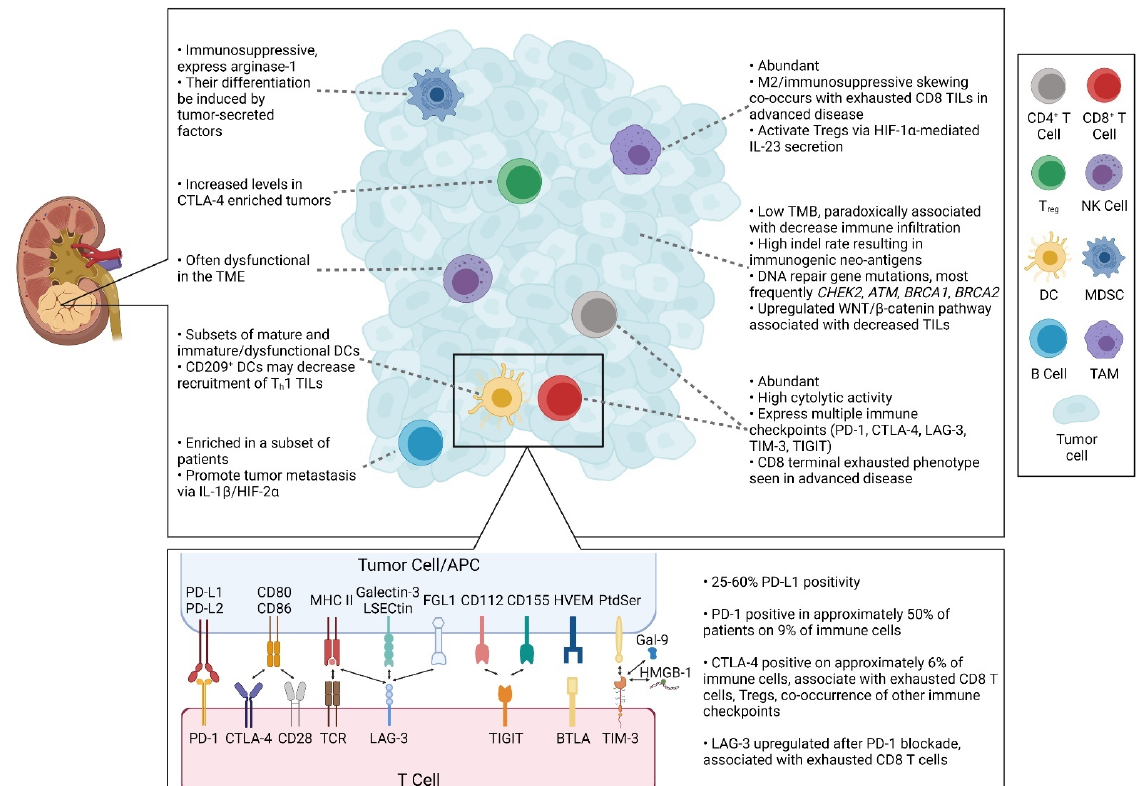
Figure 1. Representation of the RCC TME. Text highlighting key data regarding the infiltrating immune cells, tumor cells, and immune checkpoint